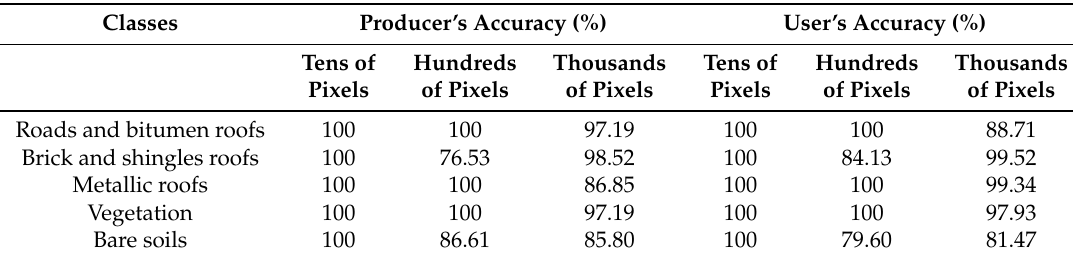
Table 3. ENVI-IDL © spectral-based SAM classification accuracy at different numbers of training sample pixels. Producer’s Accuracy (%) and User’s Accuracy (%).